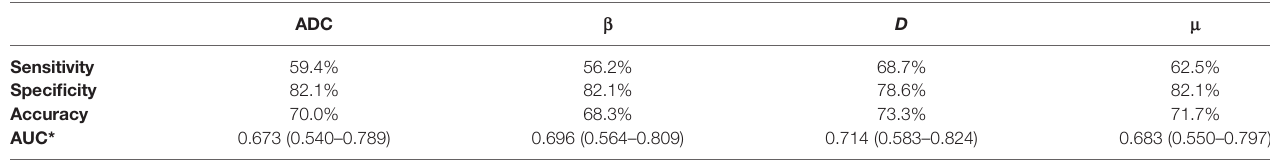
TABLE 4 | The ROC analysis results of using ADC and individual FROC model parameters to differentiate low-grade tumor from high-grade